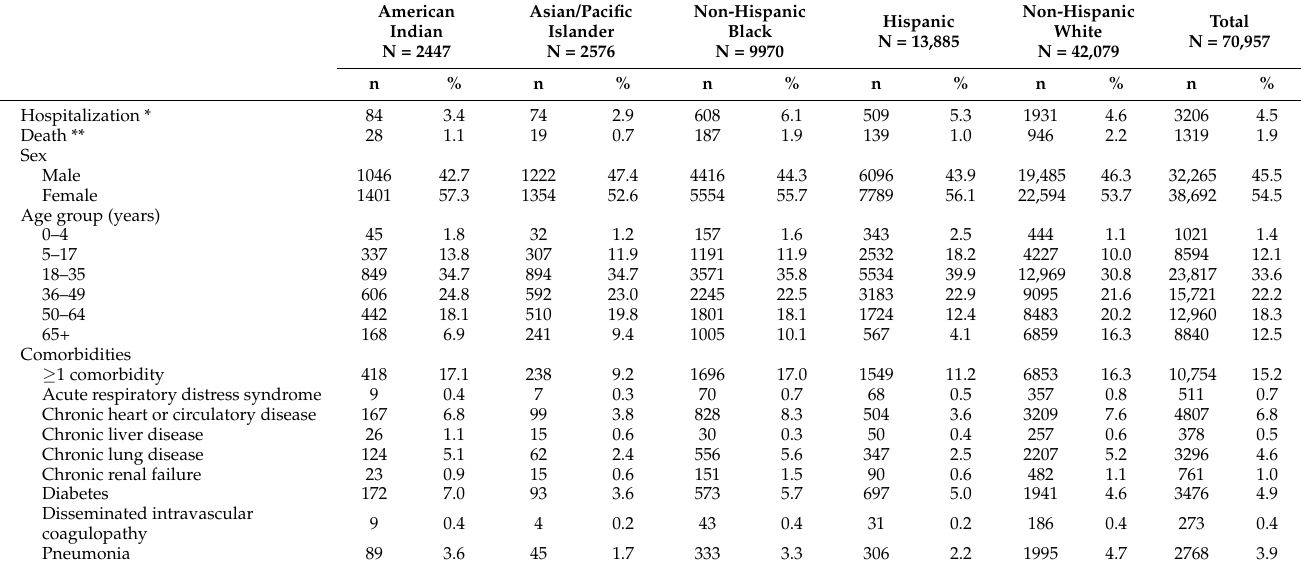
Table 2. Distribution of reported demographic characteristics among reported COVID-19 cases